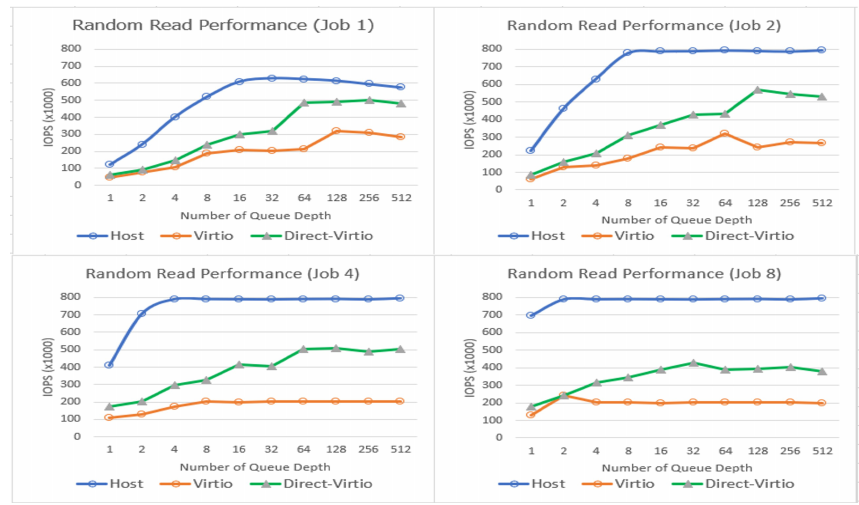
Figure 7. I/O performance comparison between Virtio and Direct-Virtio for random read pattern.